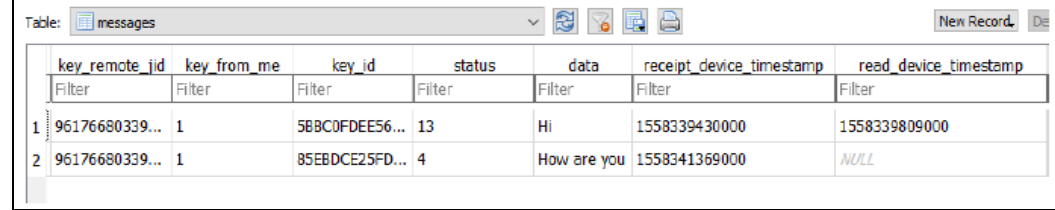
Figure 20. Message state: delivered and read messages